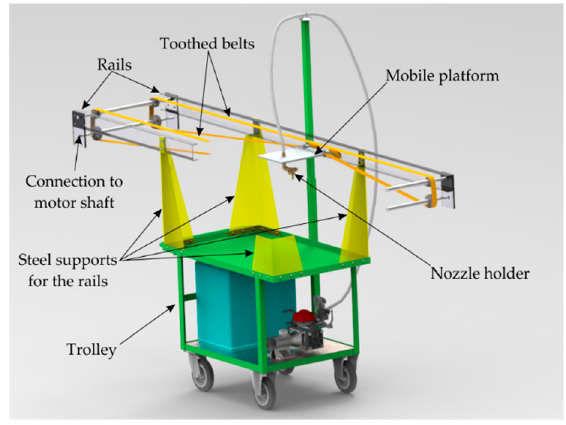
Figure 2. Partial section of the test bench showing its main components.